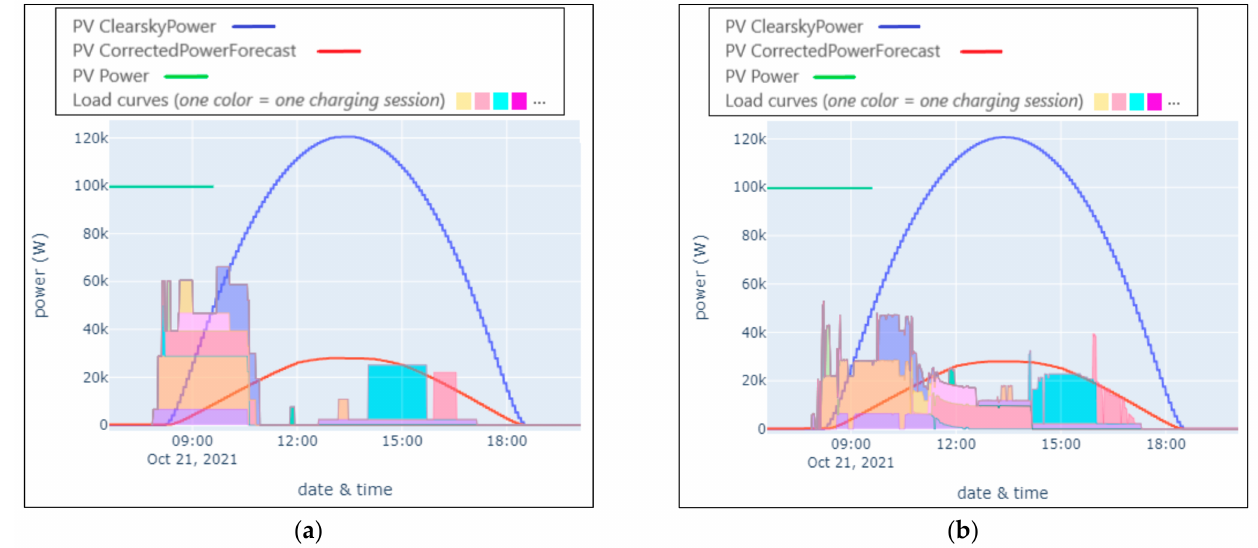
Figure 7. Results of 21st October 2021: ( a ) Stacked energies without control. The self-production rate SP u is equal to 39%; ( b ) stacked energies with control. The self-production rate SP is equal to